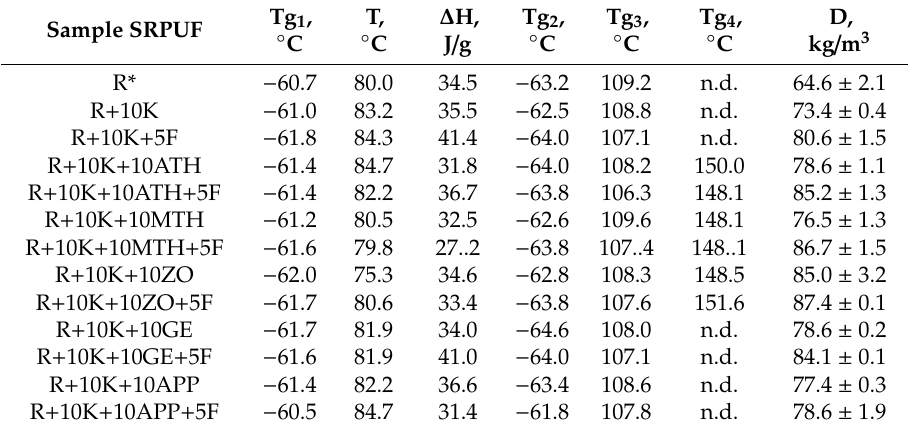
Table 2. Summary of thermal analysis results using